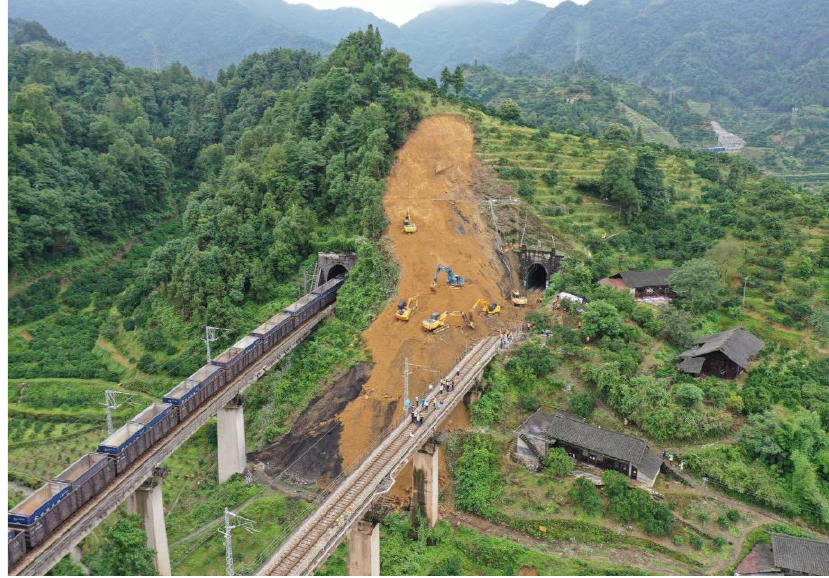
Figure 1. Landslide in engineering.